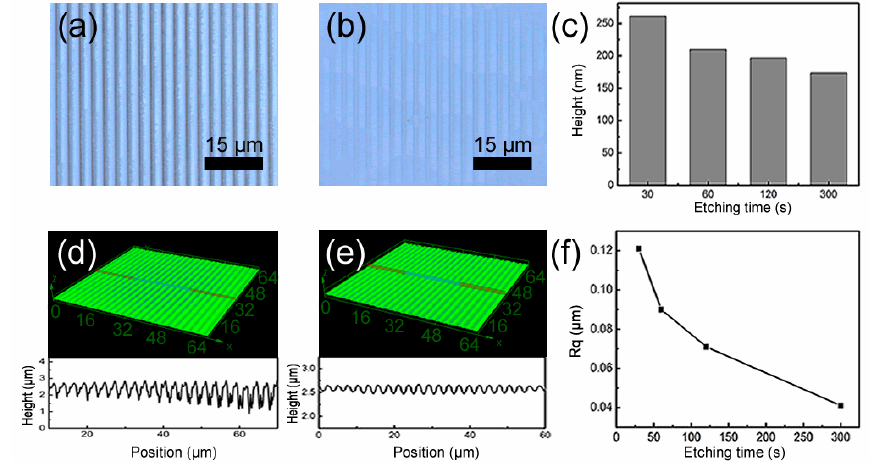
Figure 5. ( a ) Confocal photo before dry etching; ( b ) confocal photo after dry etching; ( c ) histogram of height changes with etching time; ( d ) three-dimensional topography of the microstructure and its cross-section morphology before dry etching; ( e ) three-dimensional topography of the microstructure and its cross-section morphology after dry etching; ( f ) the variation of surface roughness with etching